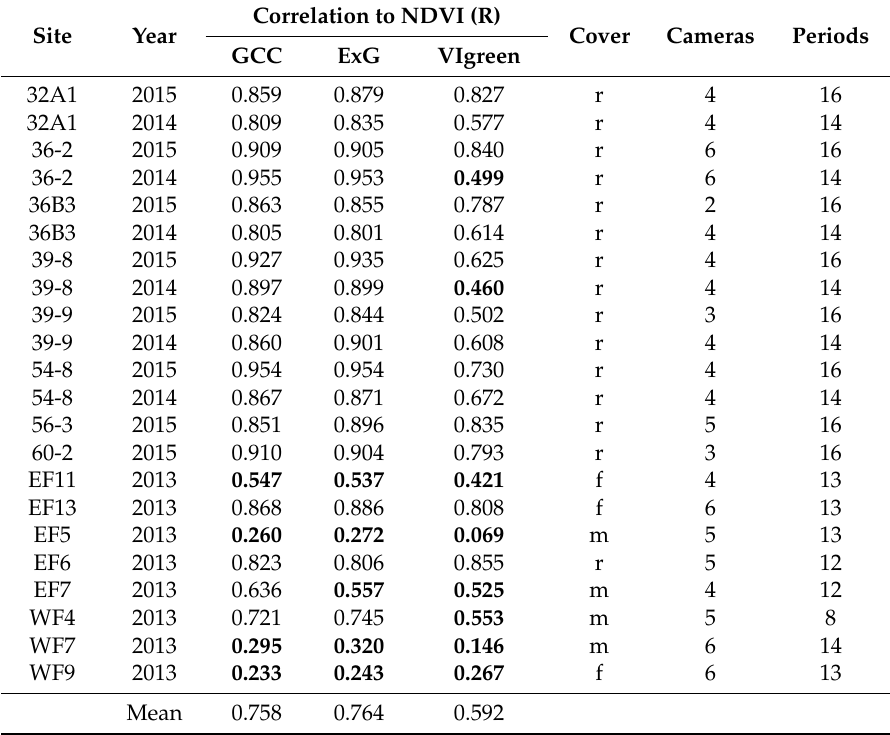
Table 1. Camera data indices’ correlation to MODIS NDVI using Pearson’s correlation value. Cover column indicates that the site was forested (f), rangeland (r) or mixed canopy (m). The Cameras column is the number of cameras used in the site analysis. Periods is the number of 16-day MODIS NDVI periods the camera data covers. Bold numbers are not significant ( α